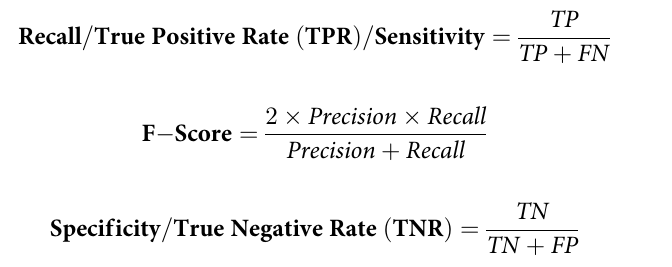
Table D : Evaluation of reduced mortality model